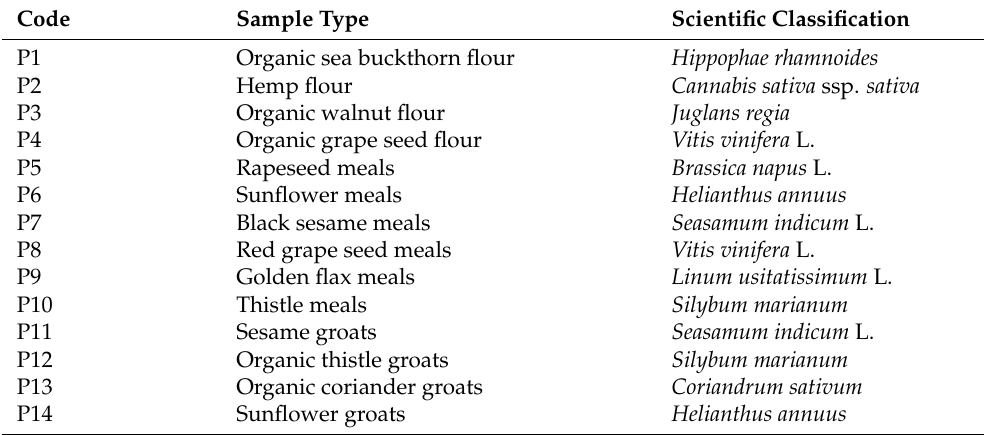
Table 1. Vegetable oil industry by-product